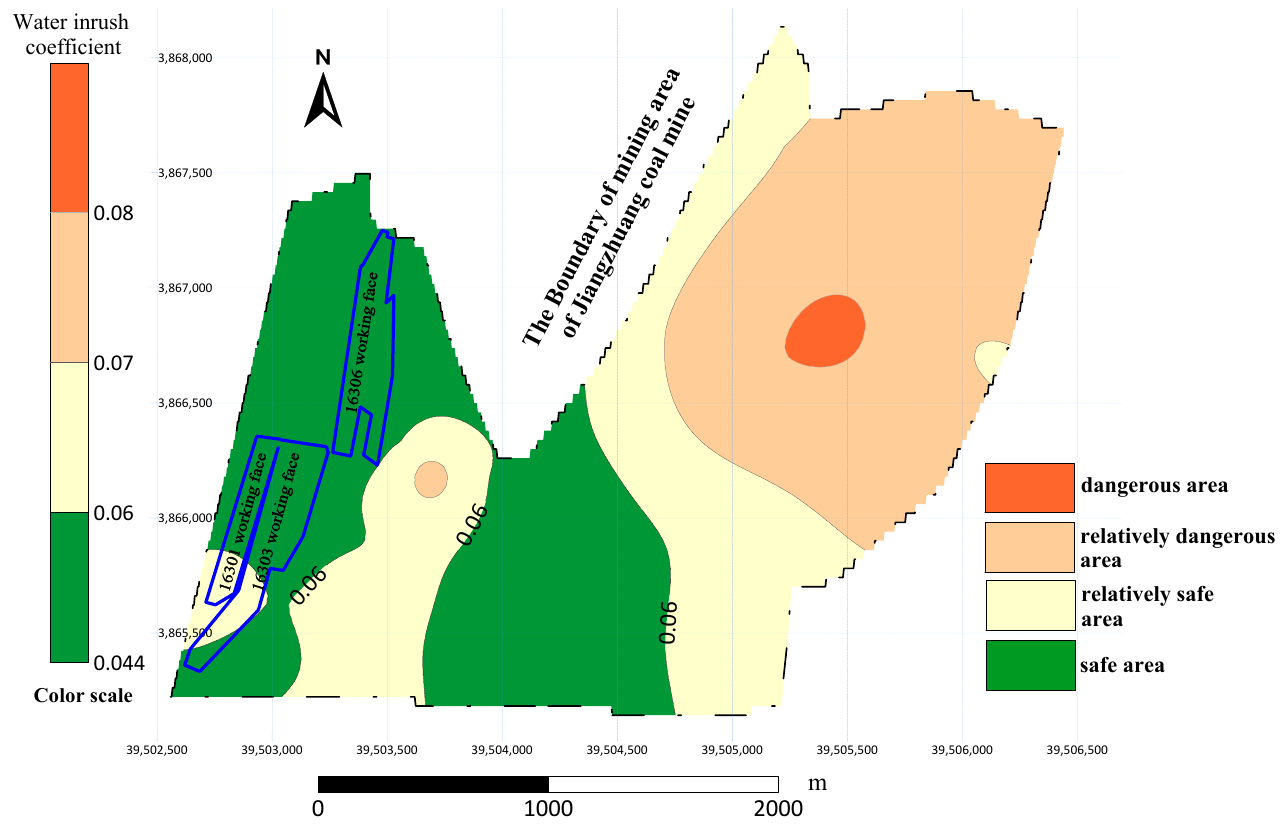
Figure 8. Risk zoning map of the water inrush coefficient method.